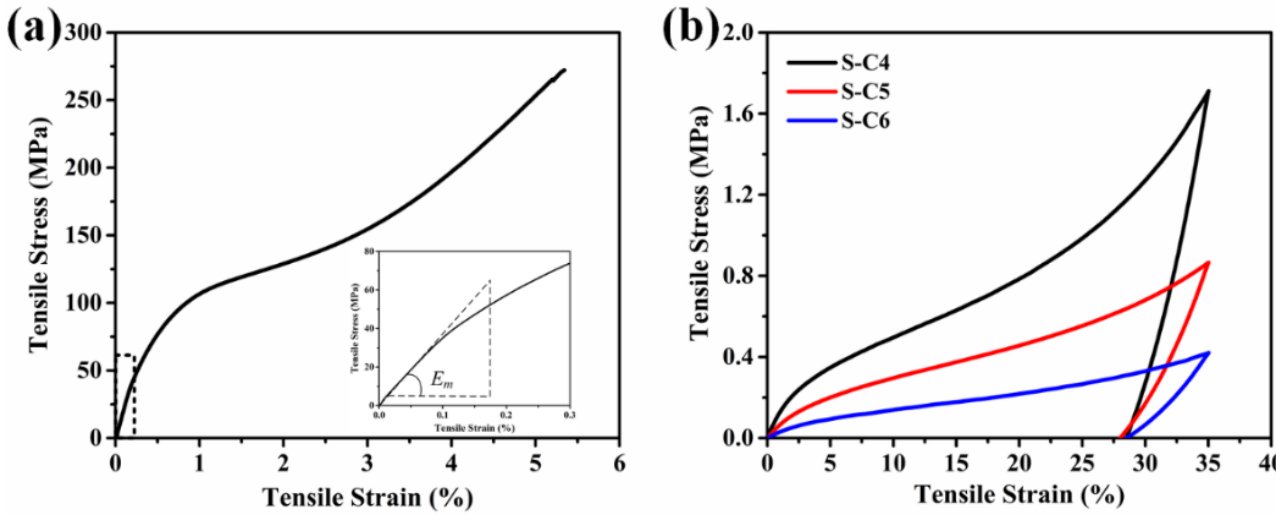
Figure 8. Tensile stress – strain responses of the SLM additive-manufactured samples: ( a ) SMA wire; ( b ) active SMA honeycomb arrays.